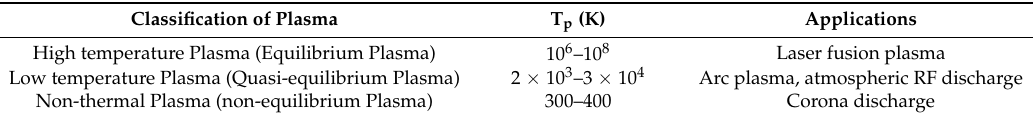
Table 2. Plasma classifications [23].